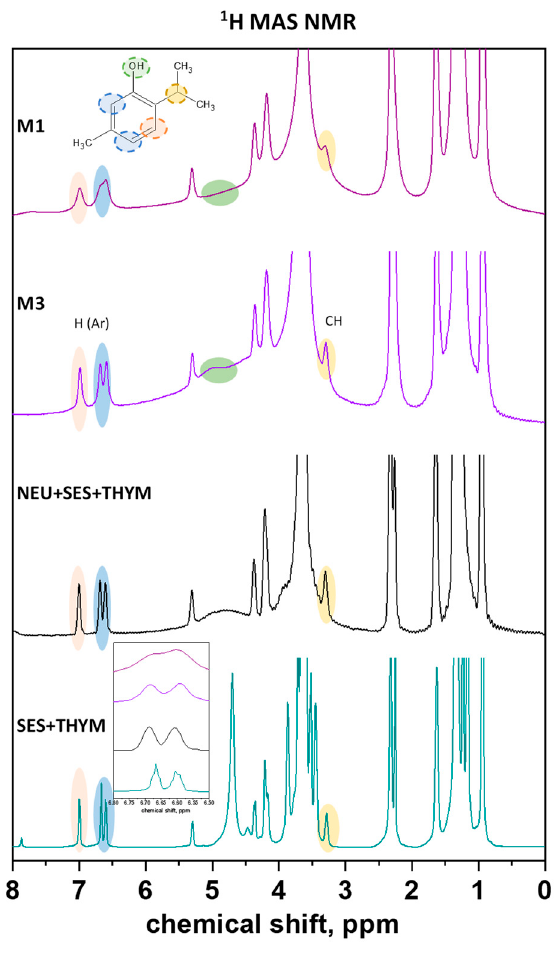
Figure 7. The 1 H MAS NMR spectra of the pellet cores M1 and M3 and the model physical mixtures Neusilin ® + SES + thymol and SES + thymol.